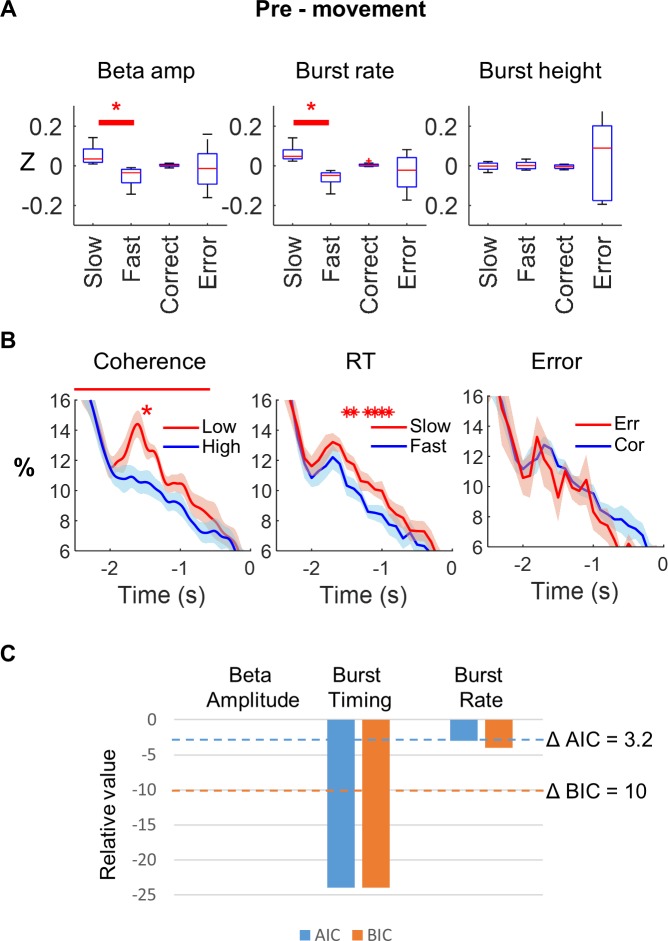
Relationship between beta and motor preparation pre-movement.(A) Pre-movement beta amplitude, burst rate, and burst height, z-score normalised within subject and split according to trials with slow versus fast response times and correct versus incorrect trials (*pFDR < 0.05). This shows a higher beta amplitude and burst rate on slow trials pre-movement but no effect of upcoming error. (B) Pre-movement burst probability is greater on low coherence than high coherence trials over the RDK period (−2.5 to −0.5 seconds; t(7) = 4.3; p = 0.004; left panel). Burst probability was also higher in trials with a slow versus fast response time between 1,500 → 900 milliseconds before movement onset (red asterisks, FDR corrected; middle panel), with no effect of upcoming error on burst probability (right panel). On the time axis, zero indicates presentation of the imperative stimulus. Data are down-sampled to 20 Hz. (C) Model comparison of three separate linear mixed effects models incorporating one of single trial beta amplitude (1), beta burst timing (2), and burst rate (3), separately, for response time in the pre-movement period. ΔAIC and ΔBIC model comparison metrics are shown (relative AIC and BIC values compared with those of the beta amplitude model). Conventional thresholds for differences are shown for AIC (blue dashed line: −3.22) and BIC (red dashed line: −10), which is equivalent to a 5× difference in probability of the models or a Bayes factor of 150, respectively. The burst timing model shows a significantly lower AIC/BIC compared with the beta amplitude model (ΔAIC = −24) and (ΔBIC = −24) for the pre-movement period, confirming that burst timing is a better predictor of response time than average single trial beta amplitude. The underlying data can be found at https://osf.io/eu6nx/. AIC, Akaike information criterion; BIC, Bayesian information criterion; FDR, false discovery rate; RDK, random dot kinematogram; RT, response time.